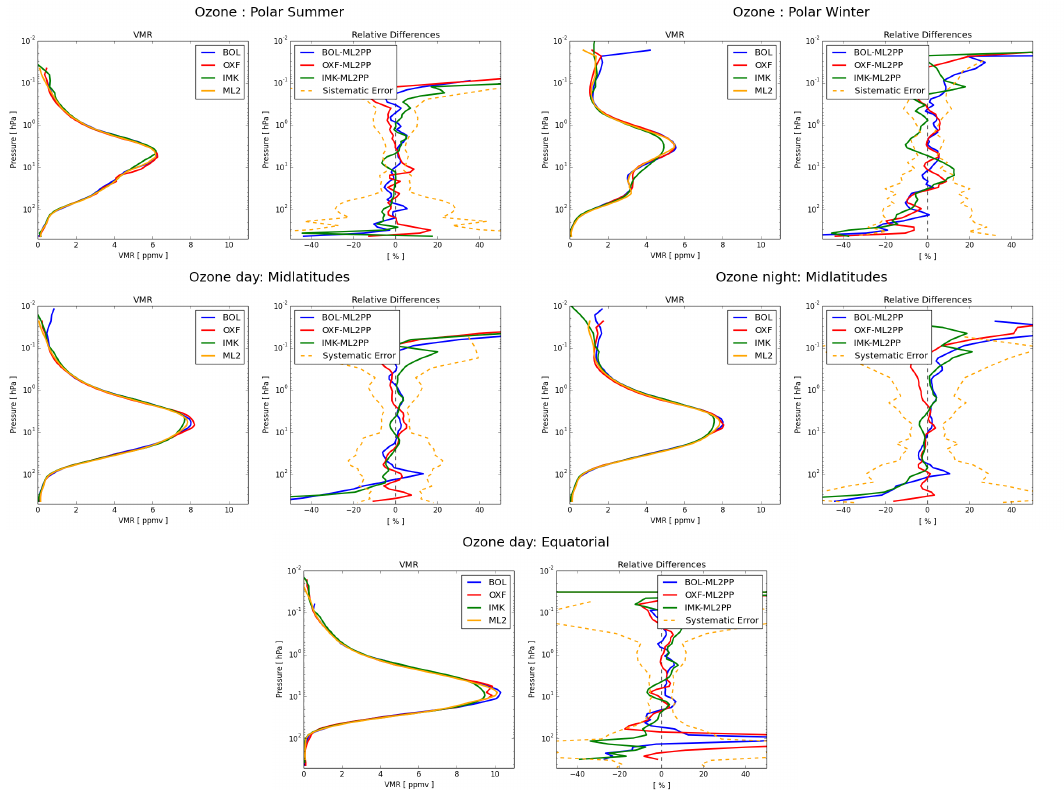
Figure 3: Mean ozone profiles of the four algorithms and mean differences with respect to ML2PP, plotted versus ML2PP estimated systematic error profile, computed for five reference atmospheres (polar summer: seasonal mean of JJA 2008 period, daytime profiles, latitude band: 90 ◦ N – 65 ◦ N; polar winter: seasonal mean of JJA 2008 period, nighttime profiles, latitude band: 65 ◦ S – 90 ◦ S; Midlatitudes day: annual mean of 2008, daytime profiles, latitude band: 20 ◦ N – 65 ◦ N; Midlatitudes night: annual mean of 2008, nighttime profiles, latitude band: 20 ◦ N – 65 ◦ N; Equatorial: annual mean of 2008, daytime profiles, latitude band: 0 ◦ – 20 ◦